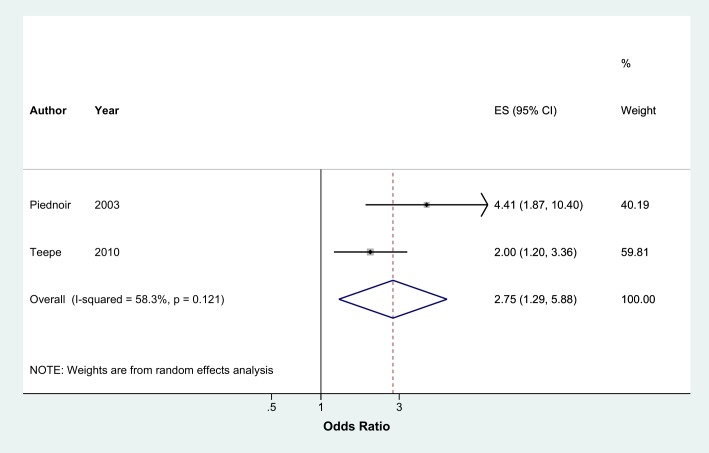
Meta-analysis of risk of community acquired pneumonia in current smokers relative to 'not current' smokers (Odds Ratio).Grey box = effect estimates from single studies. Diamond = pooled result with confidence interval. Vertical line at ‘1’ on the x-axis is the line of no effect. Weight (in %) = influence an individual study had on the pooled result.